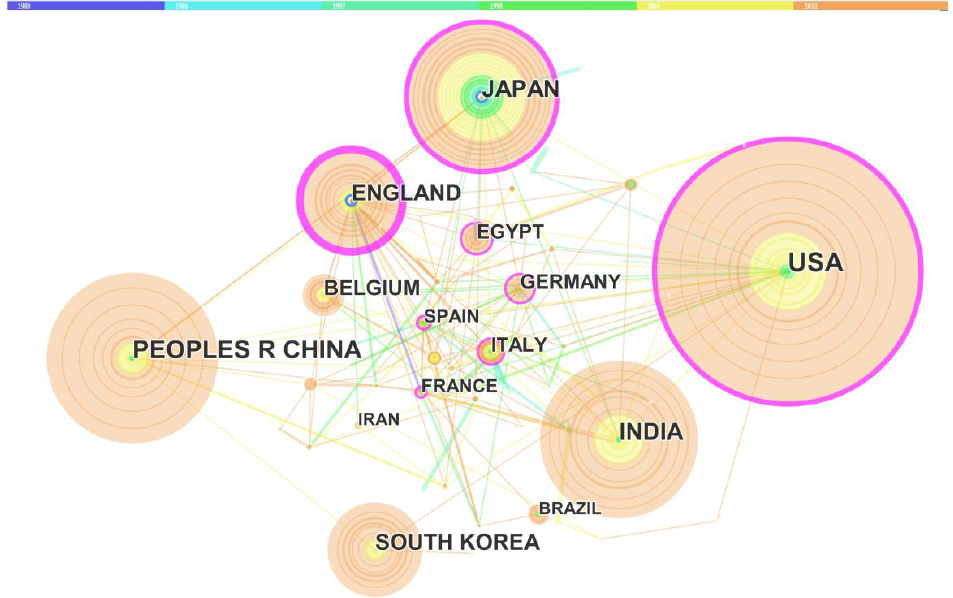
Figure 5. Country collaboration relationships network. Different colors in the figure represent different time slices, deep blue: 1980 to1985, sky blue: 1986 to 1991, pink green: 1992 to 1997, green: 1998 to 2003, yellow: 2004 to 2009 and orange: 2010 to 2015. The diameter of each circle represents the publication number of the country. The thickness of the connect line represents the intensity of country cooperation.